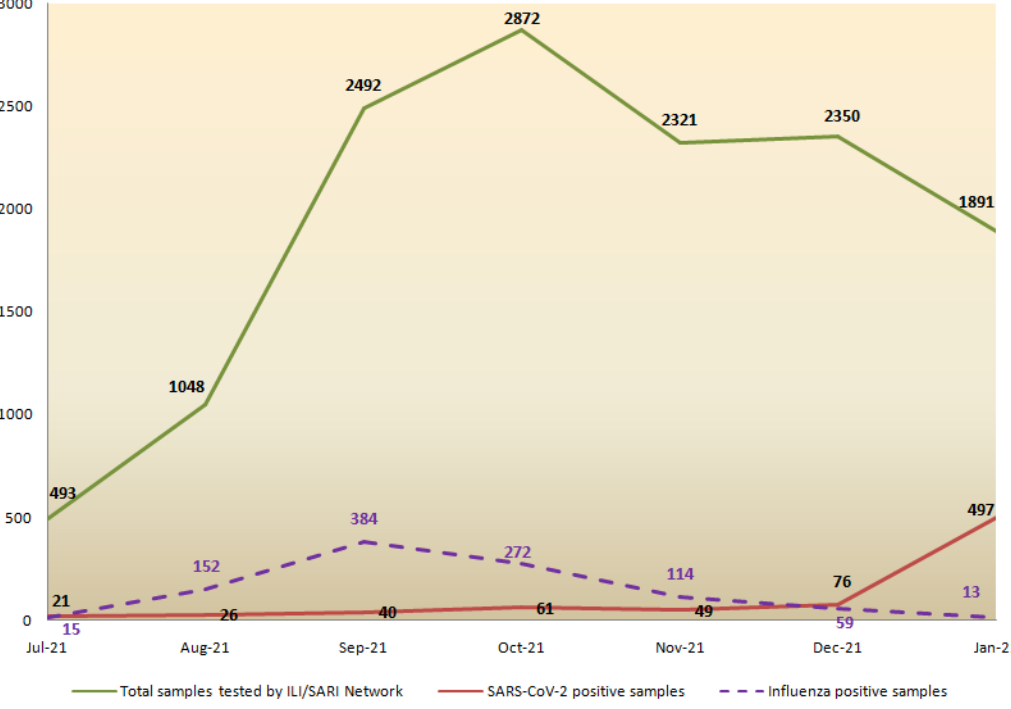
Figure 1. Monthly positivity rate of SARS-CoV-2 and influenza as detected through the ICMR (Indian Council of Medical Research) ILI/SARI (Influenza Like Illness/Severe Acute Respiratory Infection) Surveillance Network.